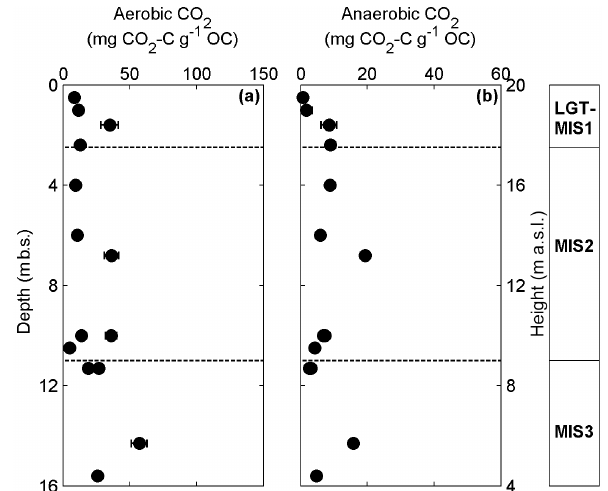
Figure 3. Depth profiles of total aerobic (a) and anaerobic (b) CO 2 production per gram of organic carbon (g − 1 OC) in sediment sam- ples from the MUO12 sequence after 134 incubation days at 4 ◦ C for deposits from the Holocene interglacial (MIS 1), including the late glacial transition (LGT), the Sartan stadial (MIS 2), and the Kargin interstadial (MIS 3). Data are mean values ( n = 3) and er- ror bars represent 1 standard deviation. Note the different scales. No CH 4 production was observed during the 134-day incubation